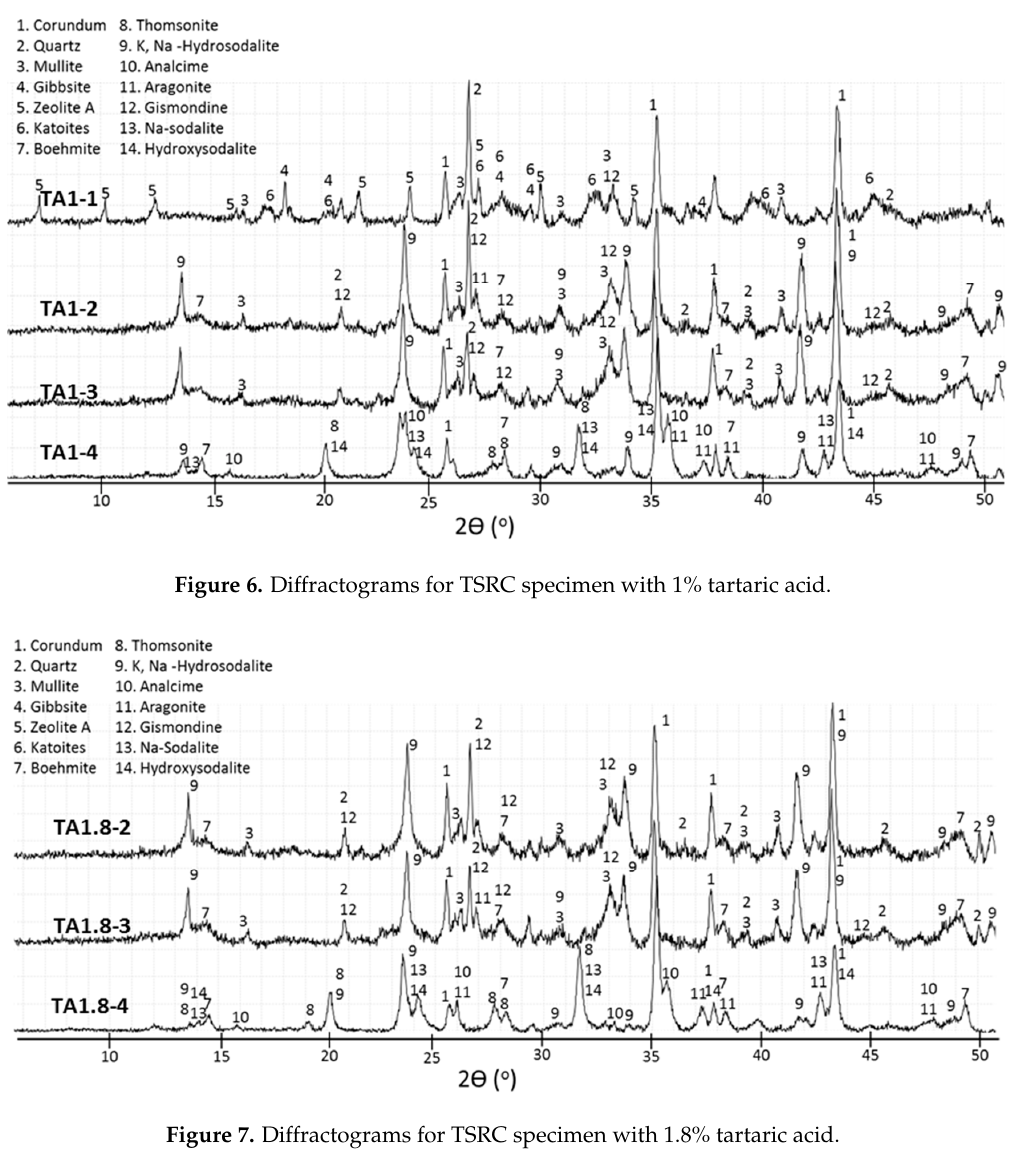
Figure 7. Diffractograms for TSRC specimen with 1.8% tartaric acid.